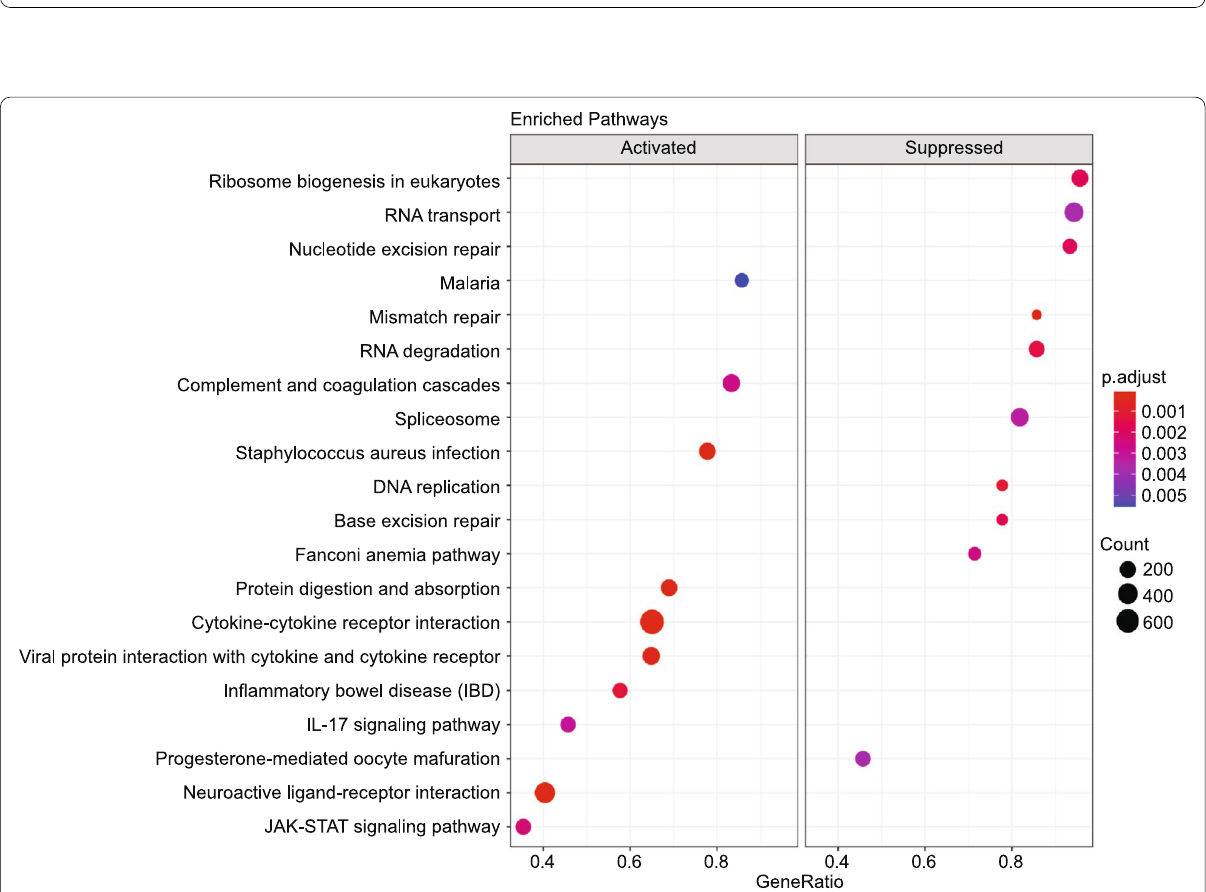
Fig. 7 KEGG Pathway analysis. KEGG-based GSEA pathways are plotted in the order of gene ratios. The dots’ size depicts the count number of the genes significantly differentiated in the KEGG pathway list, and the color represents the p -adjusted value (padj